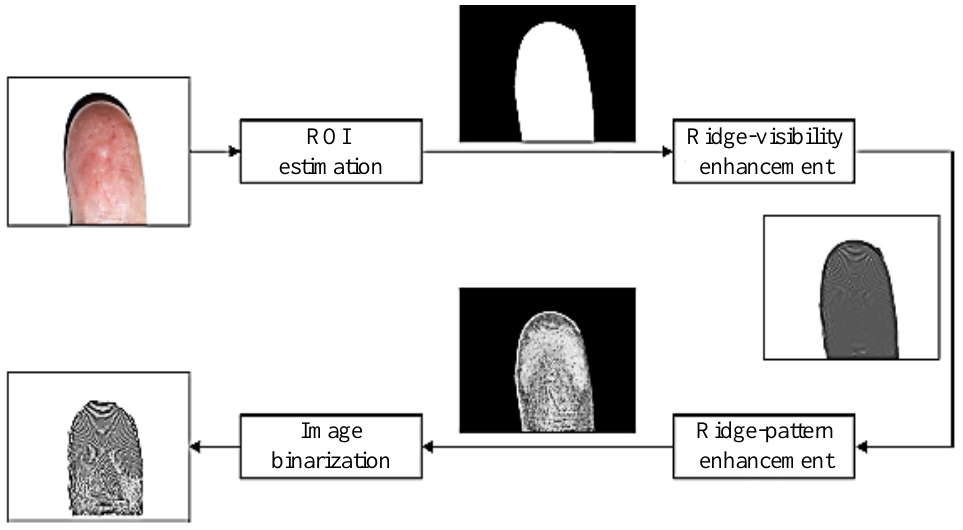
Figure 3. Simplified outline of fingerprint enhancement based on contextual